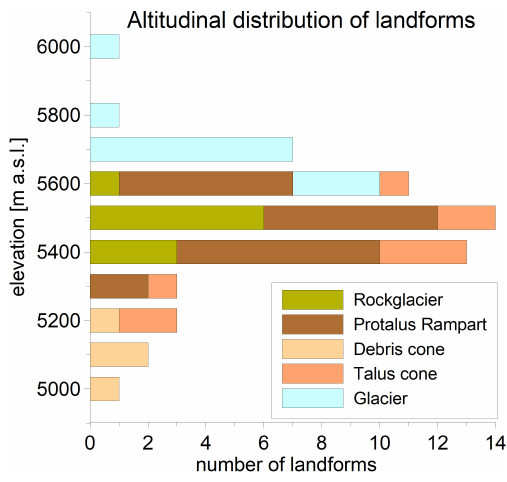
Figure 7. Altitudinal (mean) landform distribution of the Qugaqie basin derived from the landform